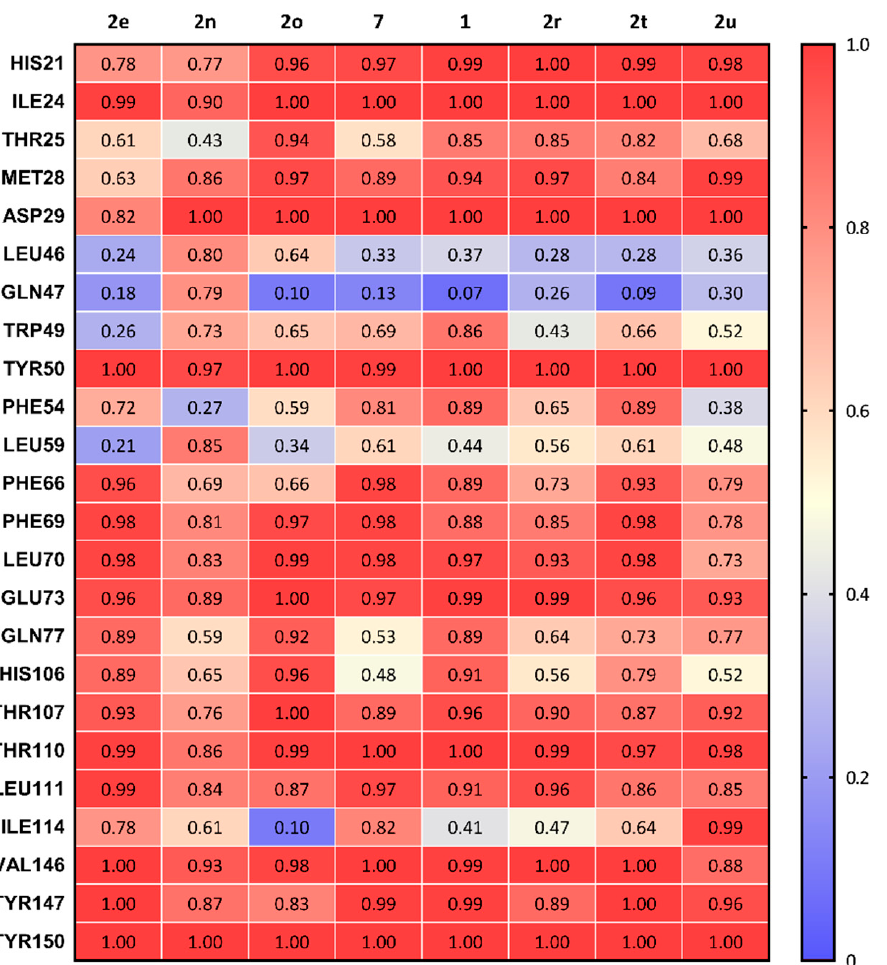
Figure 4. Summary of the frequency of all types of contacts between sigma-2 receptor and 8 compounds.